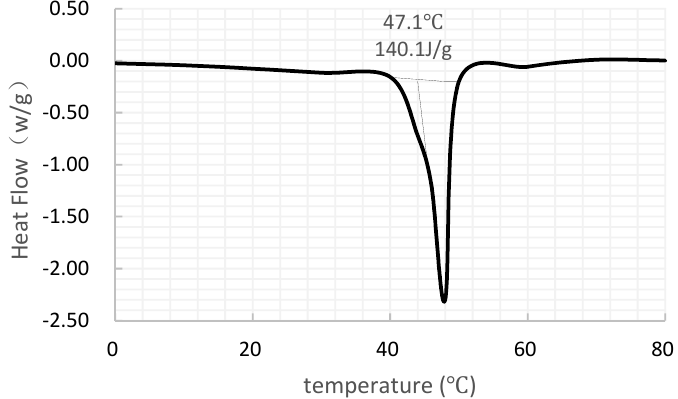
Figure 1. Differential scanning calorimeter (DSC) curves of the used paraffin.